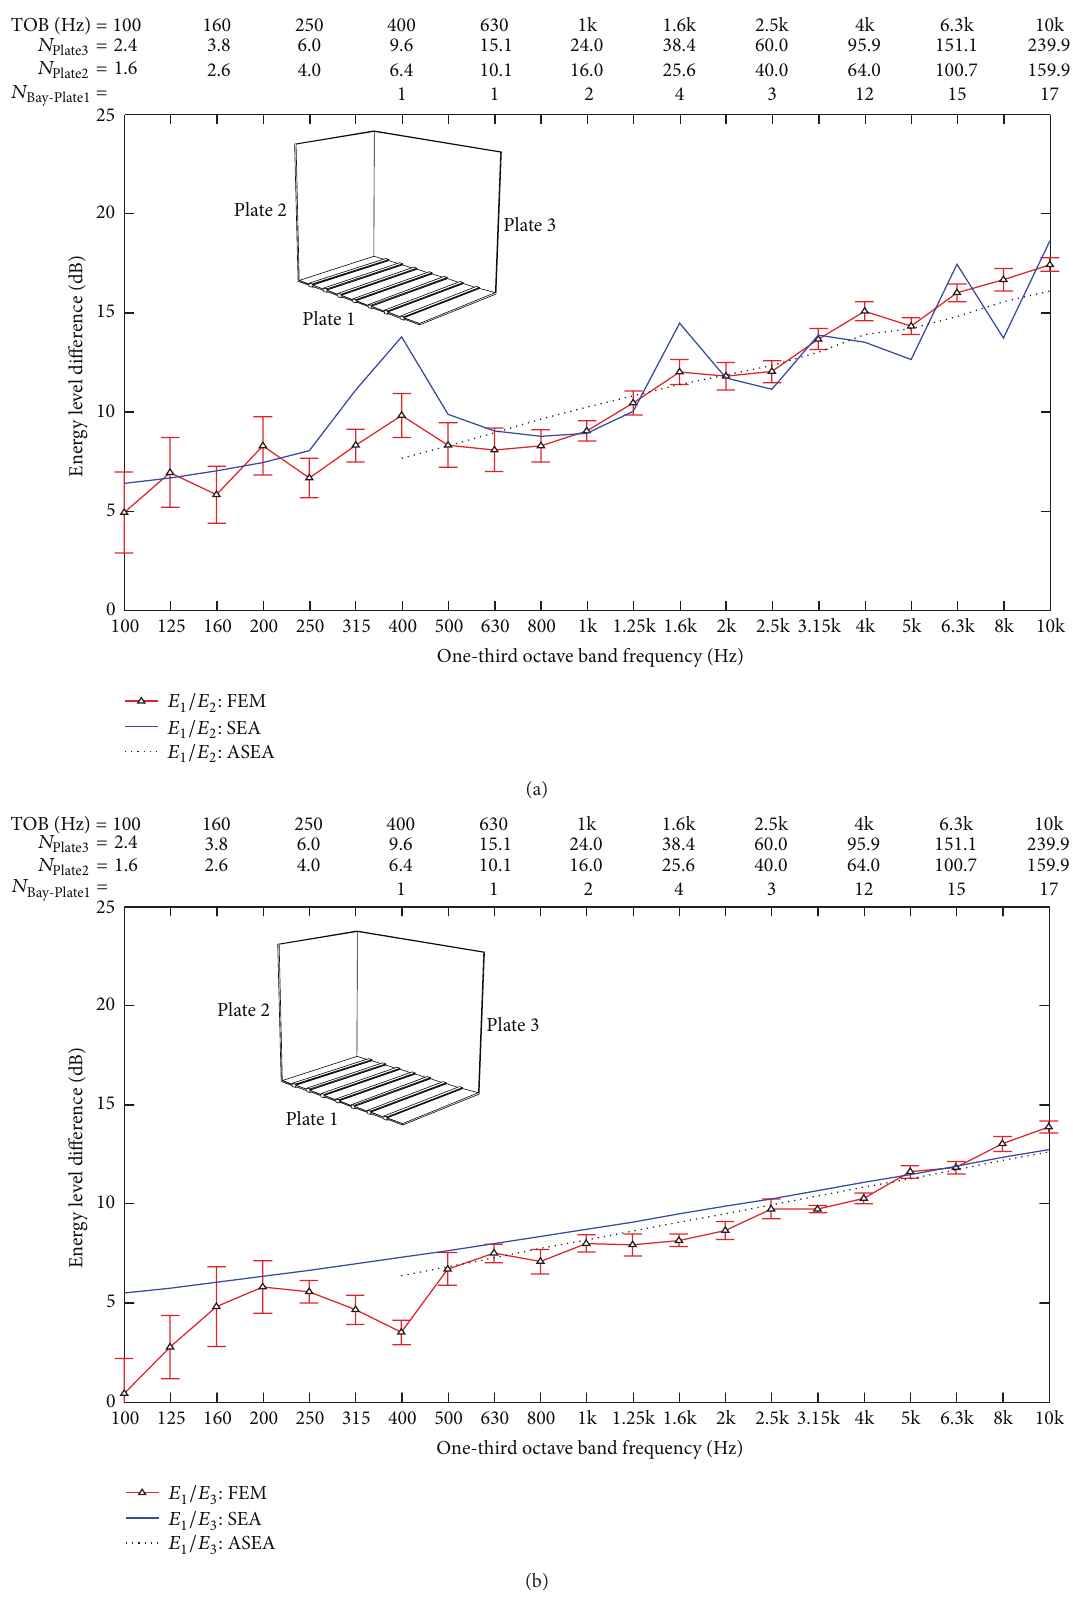
Figure 15: Three coupled plates. Excitation: Plate 1. Energy level differences between (a) the periodic ribbed plate (Plate 1) and the isotropic, homogeneous plate (Plate 2) and (b) the periodic ribbed plate (Plate 1) and the isotropic, homogeneous plate (Plate